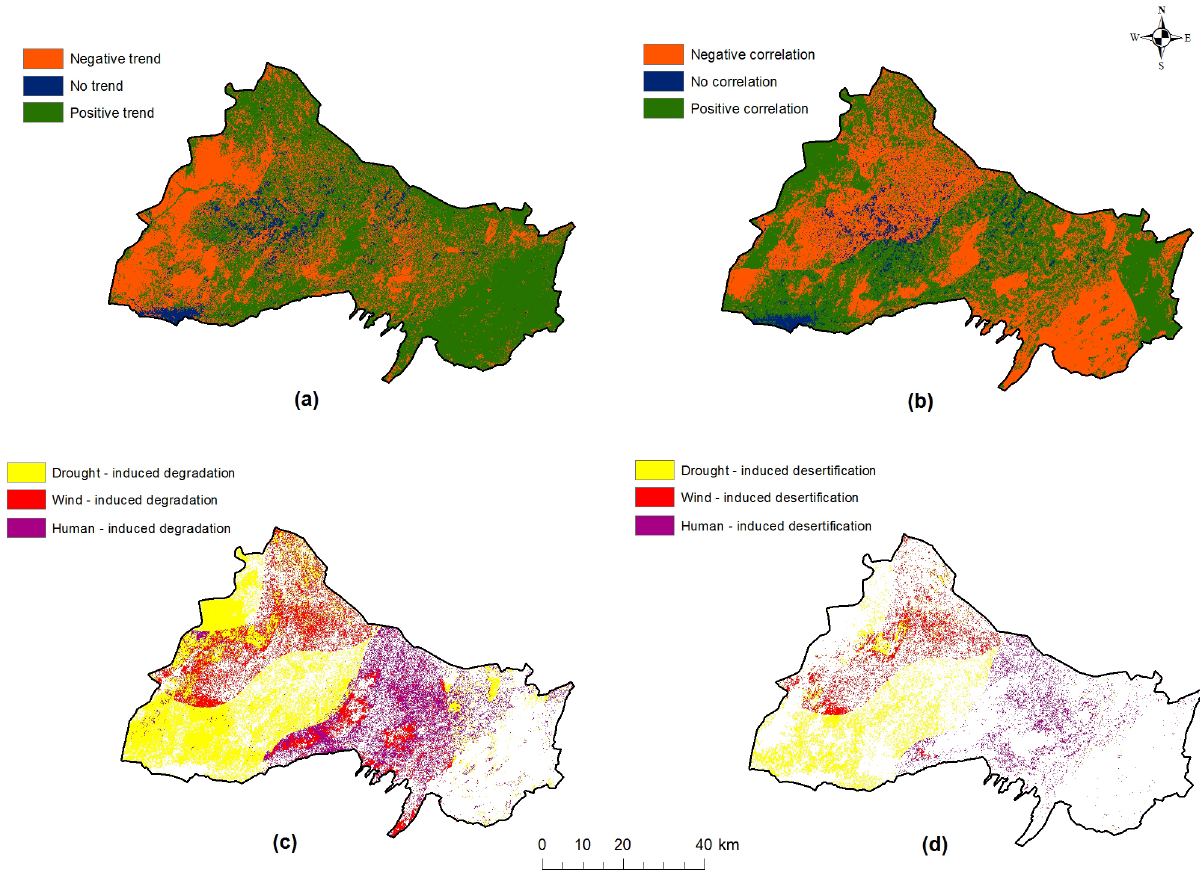
Figure 6. (a) Long-term mean NDVI observed trend. Area of no correlation in (b) is exactly coincided with no change area (a) i.e this is the place of no correlation between wind speed and NDVI due to the presence of stable/undisturbed NDVI over a period of time. (b) Correlation coefficient map for wind speed mean and NDVI predicted mean for 11 years. Eastern (low wind speed and high NDVI) and western parts (High wind speed and low NDVI) of the study region have been experiencing high negative correlation over a period of time. (c) Distribution of degraded land with respect to three crucial causative factors, namely drought, wind and human. (d) Distribution of desertified land extracted from degraded zones after the assessment with the short-term NDVI observed trend (2012–2015). Western areas of the region display combined effects of drought and wind. Though the eastern part receives adequate rain and experiences moderate temperature and wind, which is appropriate for vegetation production, the distribution of desertified land is higher due to anthropogenic activities.